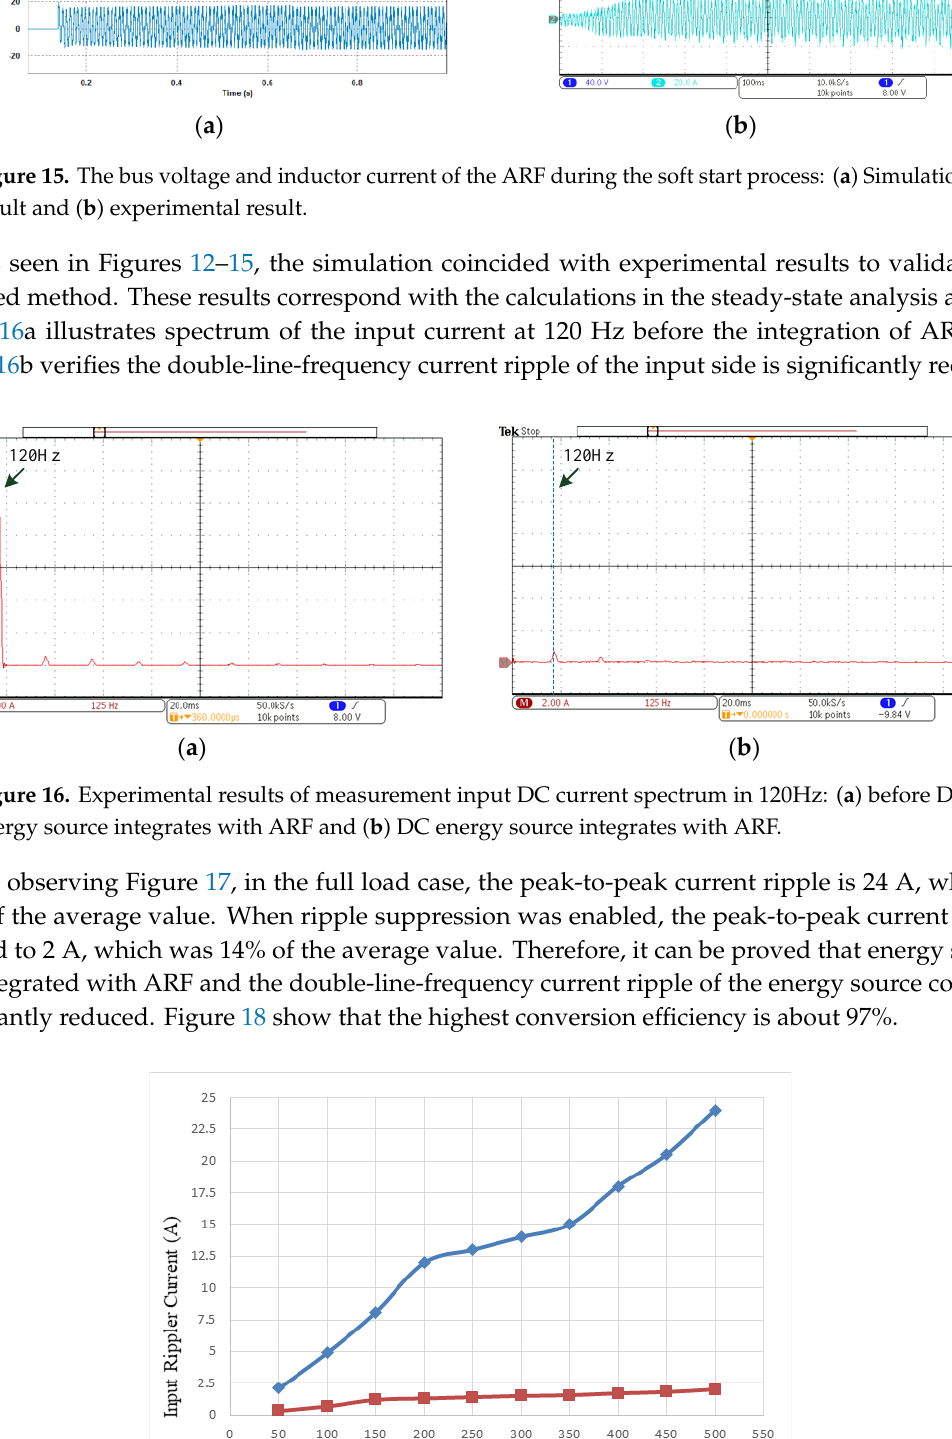
Figure 18. Conversion efficiency of the proposed method under different loads. Finally, the comparison dataset for the system integrated with, and without the ARF, the actual efficiencies are measured by a WT310 power analyzer under different loads, as listed in Table 3. Table 3. Measured ARF dataset. Without Proposed ARF With proposed ARF V S (V)